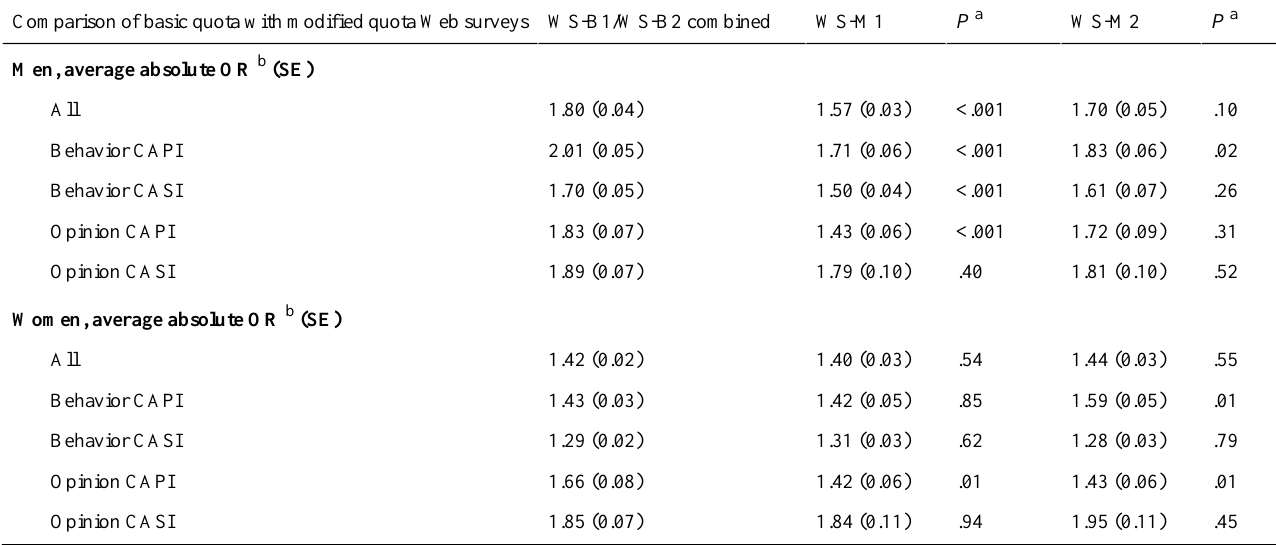
Table 4. Comparison of combined basic quota (WS-B1/WS-B2) Web surveys with first (WS-M1) and second (WS-M2) modified quota Web surveys for behavior and opinion (CAPI/CASI) variables for men and